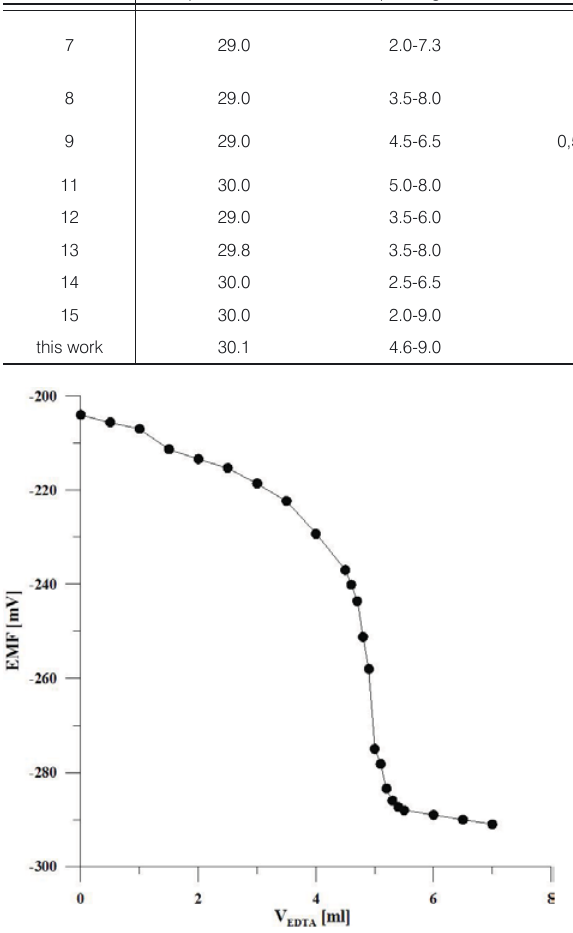
Figure 7. Potentiometric titration curve of 50 mL of 5.0×10 -4 mol L -1 Co 2+ ions with 5.0×10 -3 mol L -1 EDTA solution using the proposed sensor as an indicator